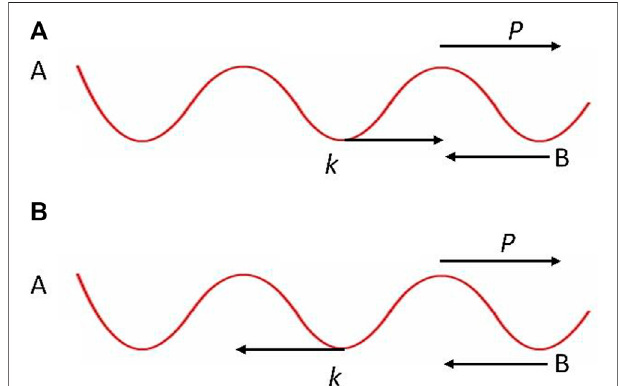
FIGURE 1 | Wave propagation in (A) RHM and (B) LHM.